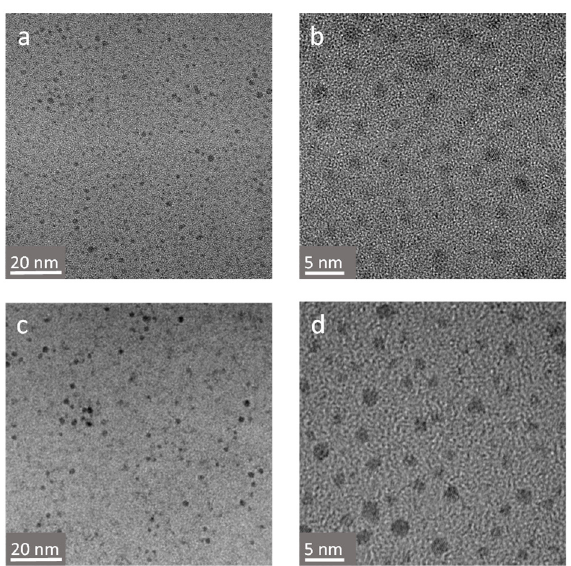
Figure 1. Transmission electron micrographs at different magnifications of ( a , b ) Au@DTDTPA and ( c , d ) Au@DTDTPA ‐ Cy5 nanoparticles.